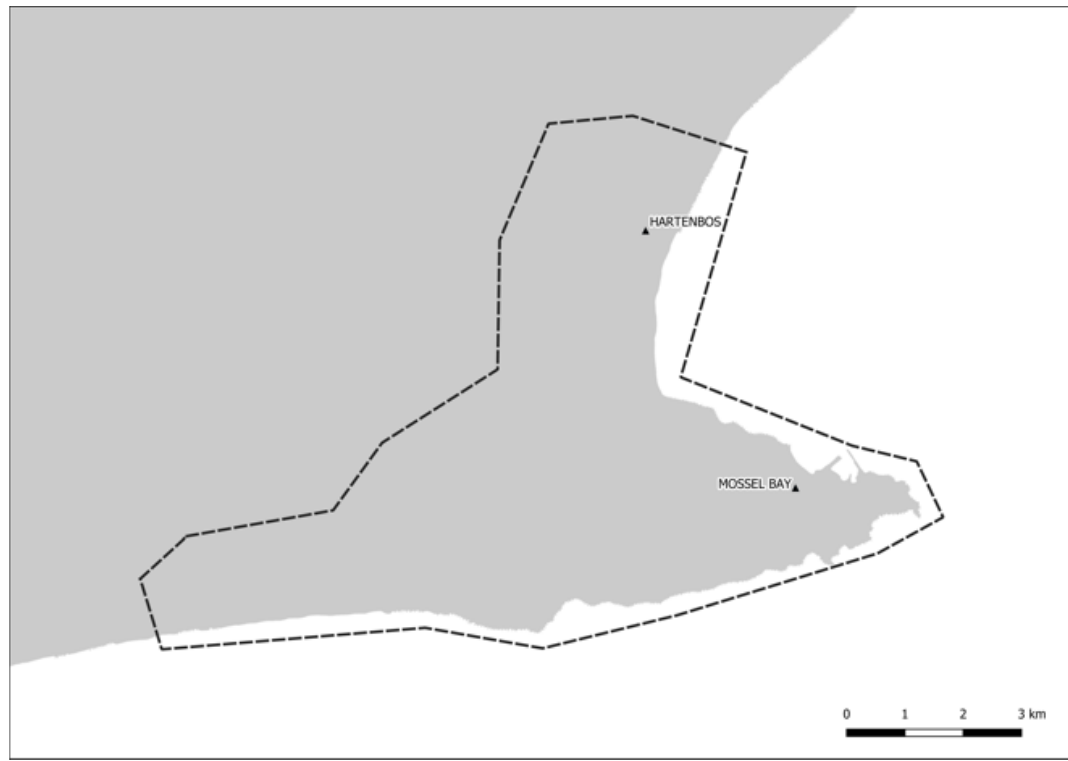
Figure 5. Coastal area for which data was collected in the second